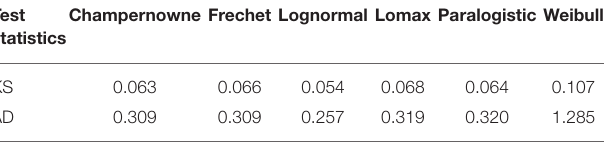
TABLE 15 | External Fraud Risk: VaR( β ) estimates, measured in millions and based on the fitted models, using truncated approach. Champernowne Frechet Lognormal Lomax Paralogistic Weibull VaR(0.99)